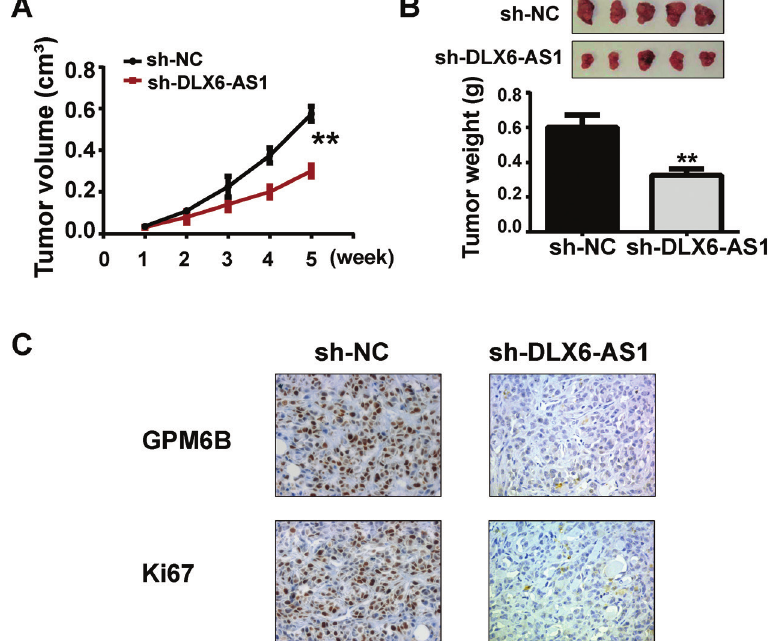
Fig. 7. DLX6-AS1 knockdown suppressed OS tumorigenesis in vivo. Mice were injected with DLX6-AS1-depleted or normal HOS cells, (a) tumor volume of each mouse was detected weekly; (b) tumor weight of each mouse was measured 5 weeks later; (c) immunohistochemistry staining was performed to detect the GPM6B and Ki67 protein expression levels. NC, negative control. ** P < 0.01, versus sh-NC